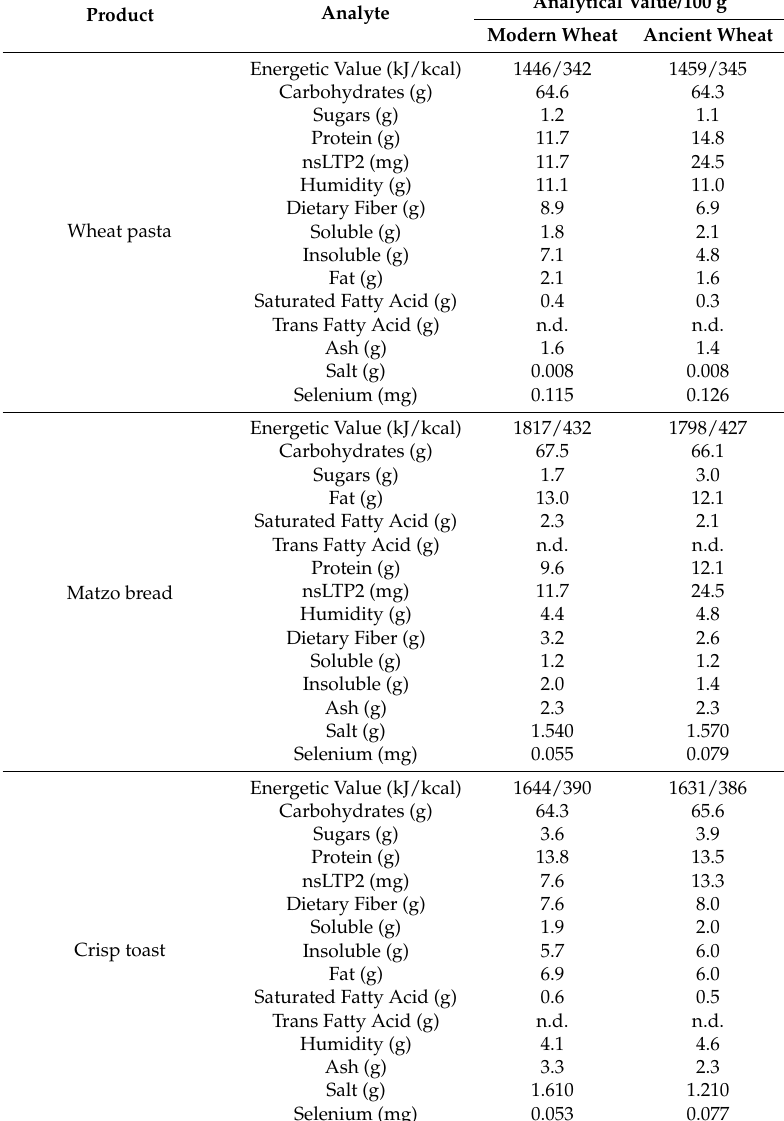
Table 1. Nutrient characterization of the tested